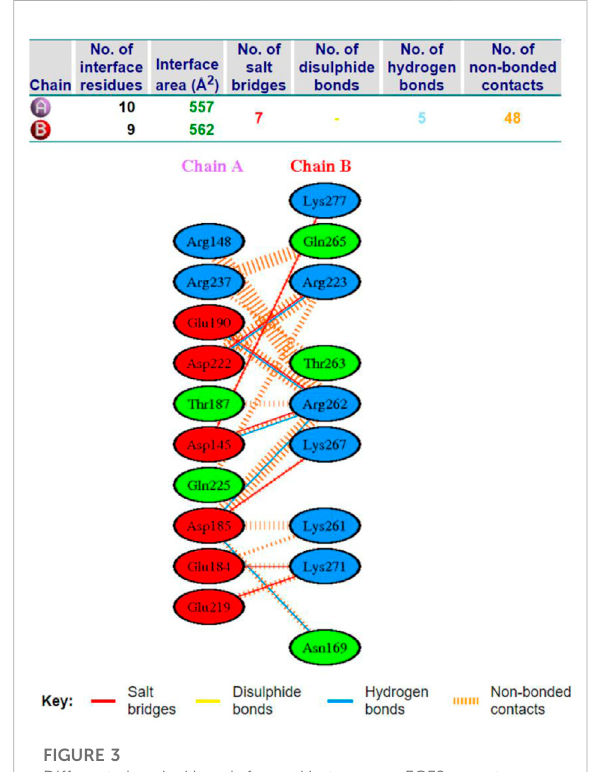
FIGURE 3 Different chemical bonds formed between an FGF2 receptor and AF15